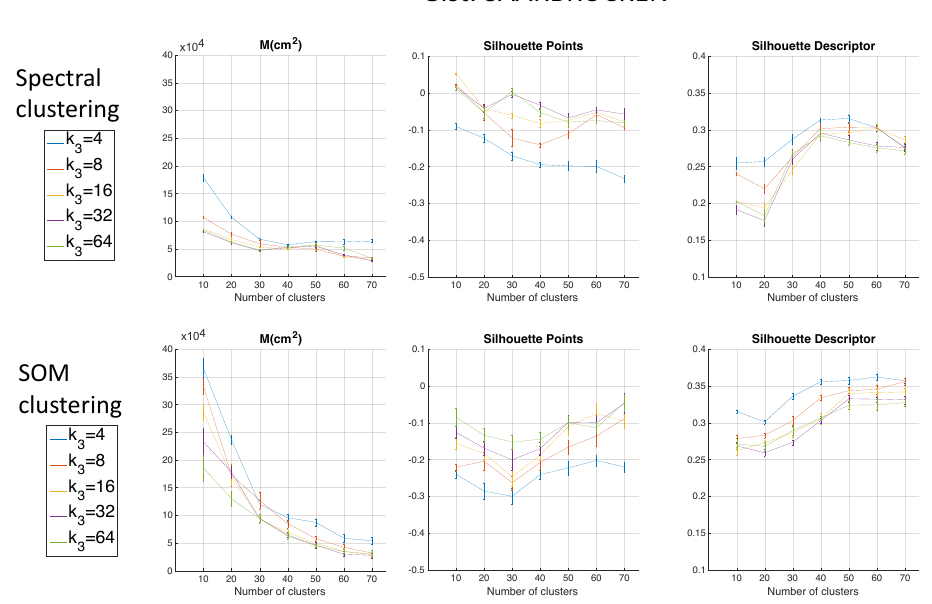
Figure 14. Results of the two clustering methods: average moment of inertia, average silhouette of points, and average silhouette of descriptors vs. number of clusters, when using gist in the Saarbrücken